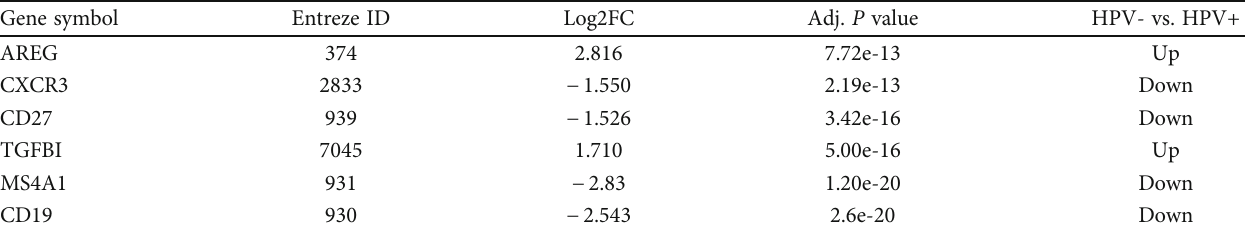
Figure 6: Marker genes associate with prognostic signatures. (a) Biological process enrichment analysis on di ff erentially expressed genes between HPV-TIL and HPV +TIL groups. (b) Violin plot of marker genes in cell clusters in single-cell resolution. (c) Di ff erentially expressed genes comparison between HPV-TIL and HPV +TIL groups based on TCGA data. (d) Overall survival analysis on six marker genes based on HPV types and gene expression levels. Table 1: The di ff erential expression status of six marker genes related to